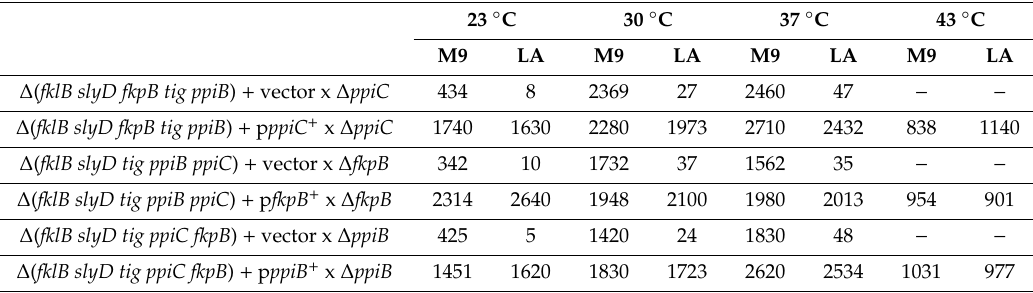
∆ ( fklB slyD tig ppiB ppiC ) + vector x ∆